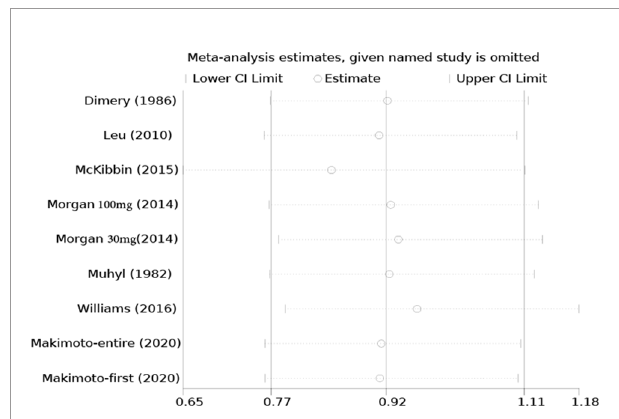
FIGURE 10 | Sensitivity analysis of the effect of individual studies on the pooled ORs for mannitol and cisplatin-induced